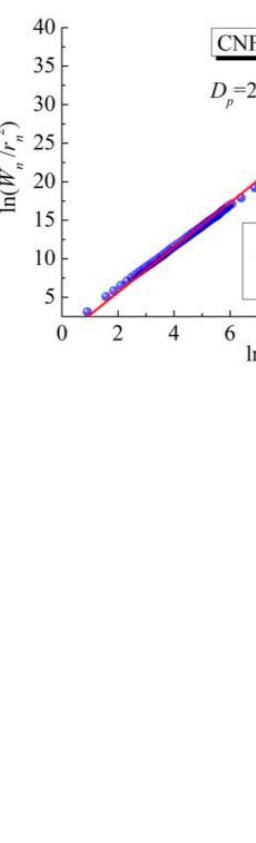
Figure 18. The relationship between D p and CNFs dosage.